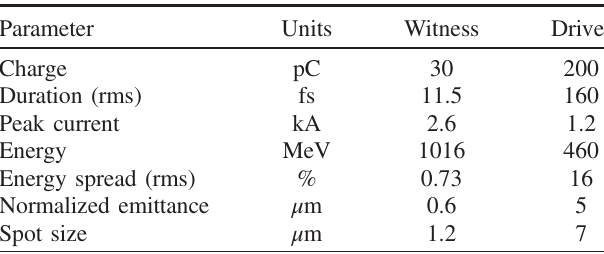
TABLE I. Witness and driver bunches parameters at the exit of the PWFA module.